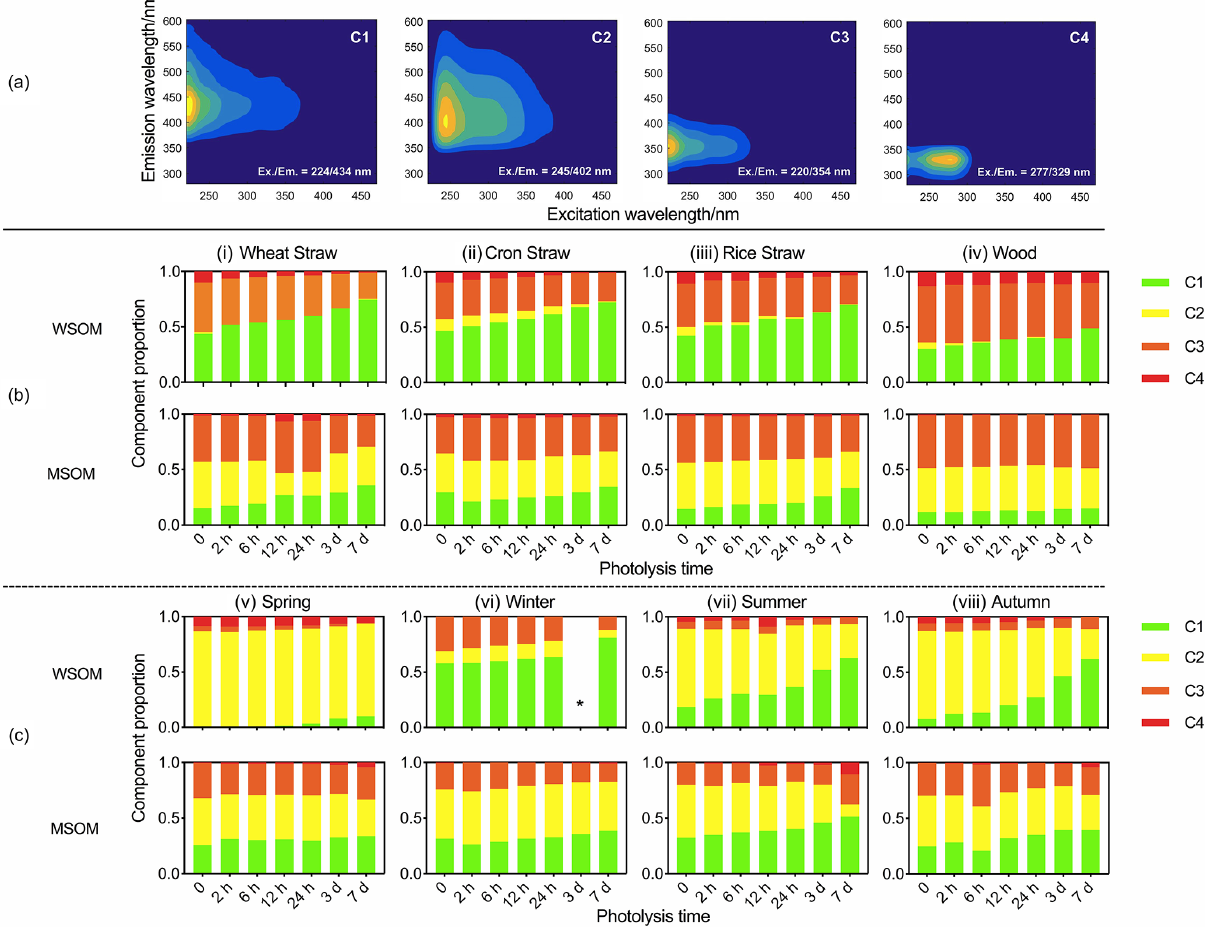
Figure 3. (a) EEM spectra of fluorophores. (b) Changes in proportion of fluorophores in POA. (c) Changes in proportion of fluorophores in ambient PM. ∗ The data of 3d photolysis of water-soluble fluorophores in winter are